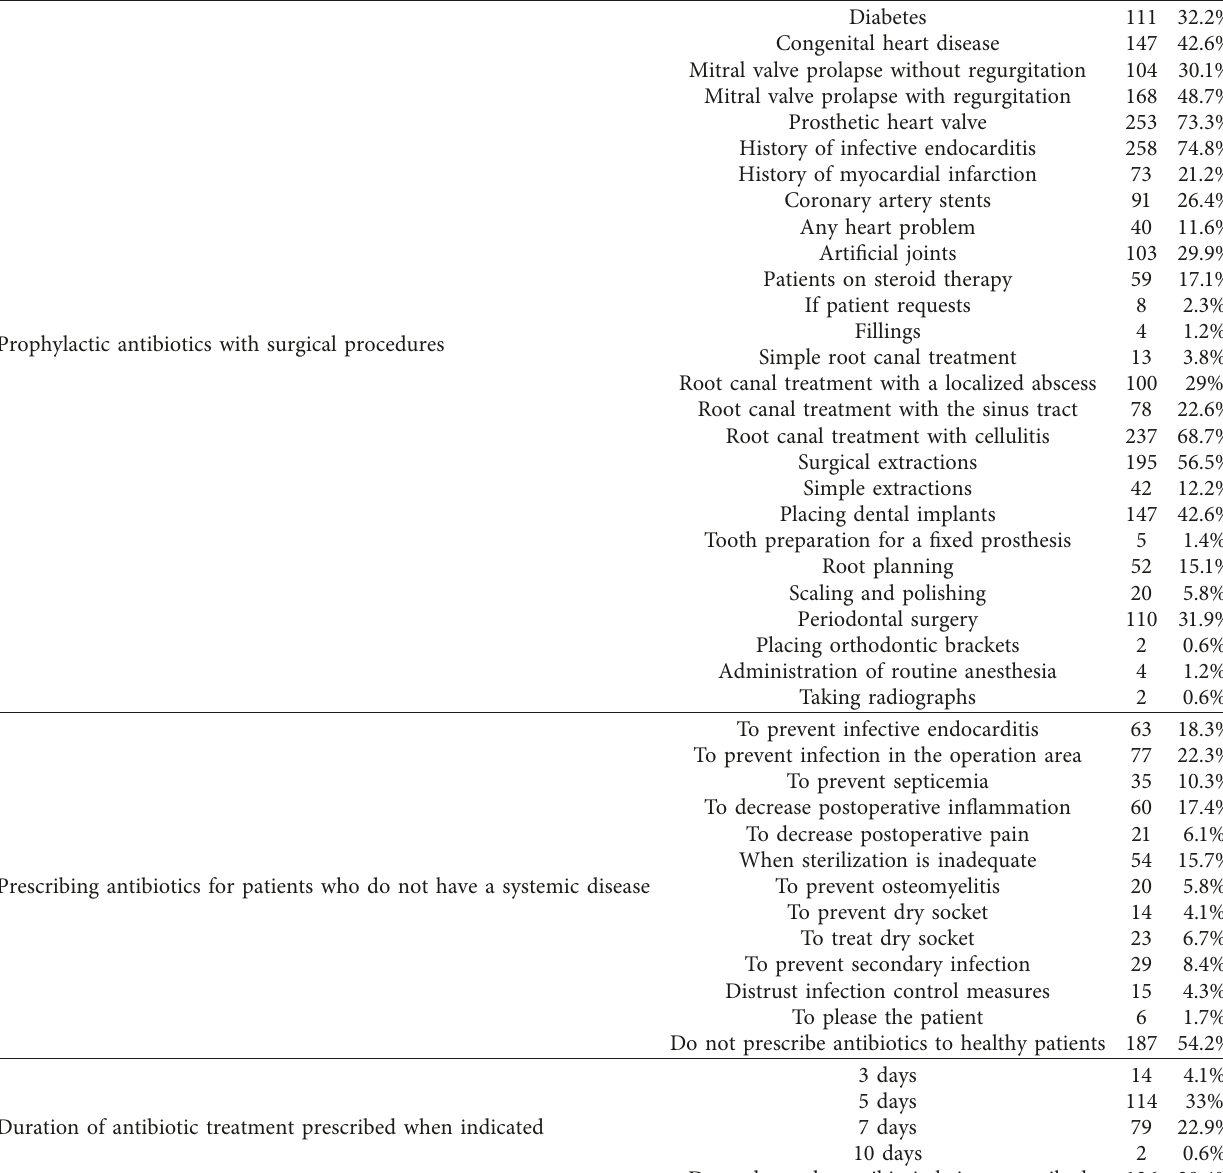
Table 3: Dentists’ antibiotics prescribing habits.